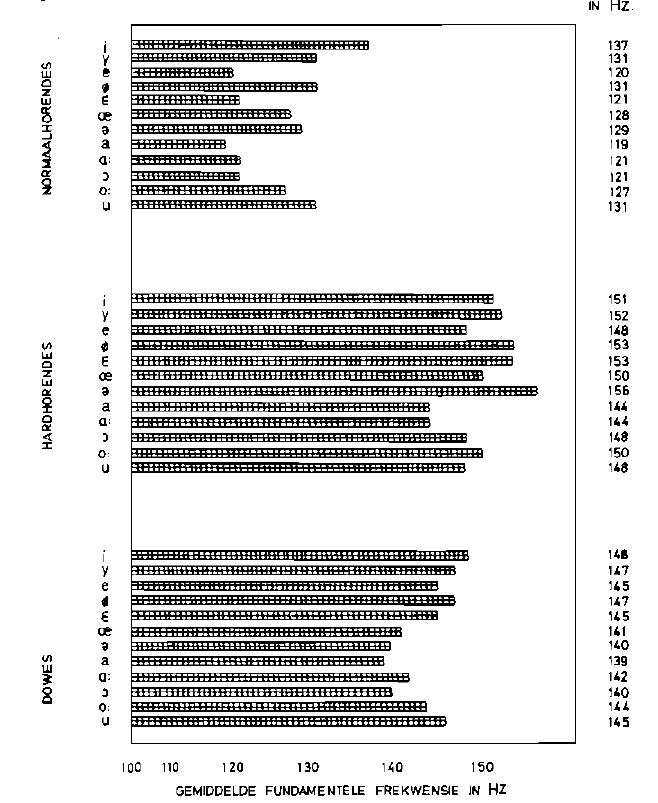
Figuur 2 Die gemiddelde fundamentele frekwensie (Fo) van vokale soos deur normaalhorende en gehoor- gestremde sprekers